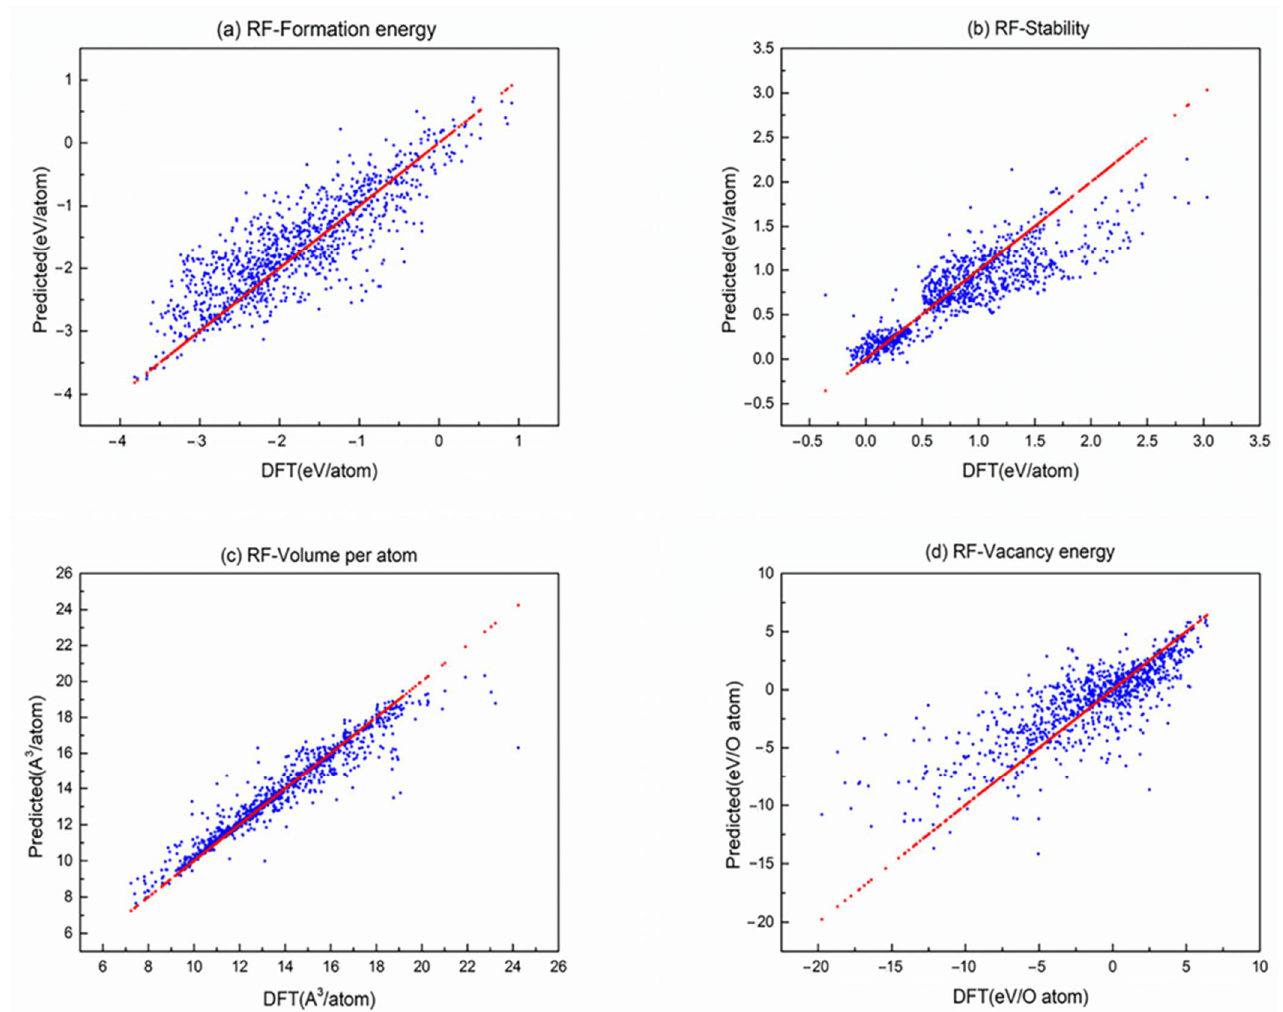
Figure 5. Fitting diagram based on RF predicted value and DFT calculated value: ( a ) fitting diagram for formation energy, ( b ) fitting diagram for stability, ( c ) fitting diagram for volume, and ( d ) fitting diagram for formation energy of oxygen vacancy. Red points work as reference points, which is ideal values obeyed y = x.